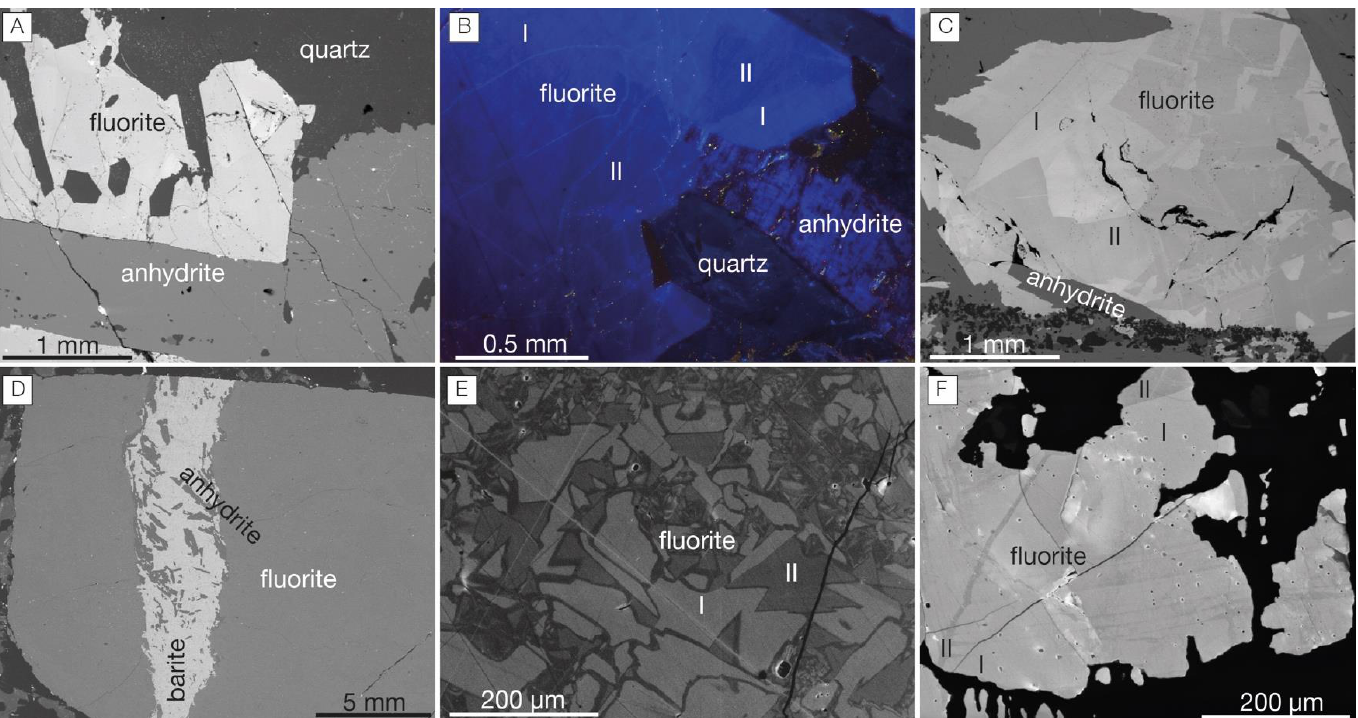
Figure 3. ( A ). BSE image of hydrothermal fluorite, quartz and anhydrite from ABB Well B. ( B ): Colour-CL image of hydrothermal fluorite, quartz and anhydrite. Sector zoning (generation* I and II) is a prominent feature in fluorite. Anhydrite shows characteristic deformation lamellae. Quartz also displays growth textures that indicate a successive growth under varying conditions. ( C ): BSE image of a large fluorite grain with pronounced sector zoning and cyclical growth patterns. At least two distinct fluorite generations (I and II) can be observed in this sample from ABB Well C. ( D ): BSE image of a barite-anhydrite vein in fluorite from ABB Well D . Barite and anhydrite represent the last stage of this hydrothermal event. Due to the large contrast difference between barite and fluorite the growth patterns in fluorite are barely visible in this image. ( E ): CL image of fluorite from LSB Well A displaying the intricate network of fluid pathways and growth textures typical of complex sectoral growth (e.g., fir tree structures, see Discussion, Figure 7G). Two main generations (I and II) can be distinguished here as well. ( F ): Fluorite from LSB Well B showing pronounced cyclical growth patterns typical for a combination of sectoral and oscillatory zoning (CL image, see Discussion, Figure 7F). Two distinct fluorite generations (I and II) can be observed in this sample. * ’generation’ is a term that in these cases does not necessarily denote an attribution to different fluid generations and a difference in age (as discussed in Section 5).